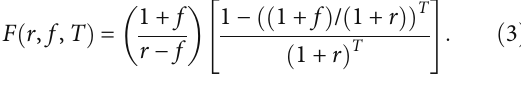
Figure 1: SPV cell equivalent circuit.